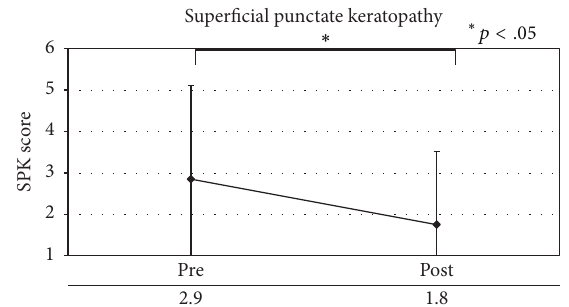
Figure 6: Decreased meibum secretion in patients with meibomian gland dysfunction.